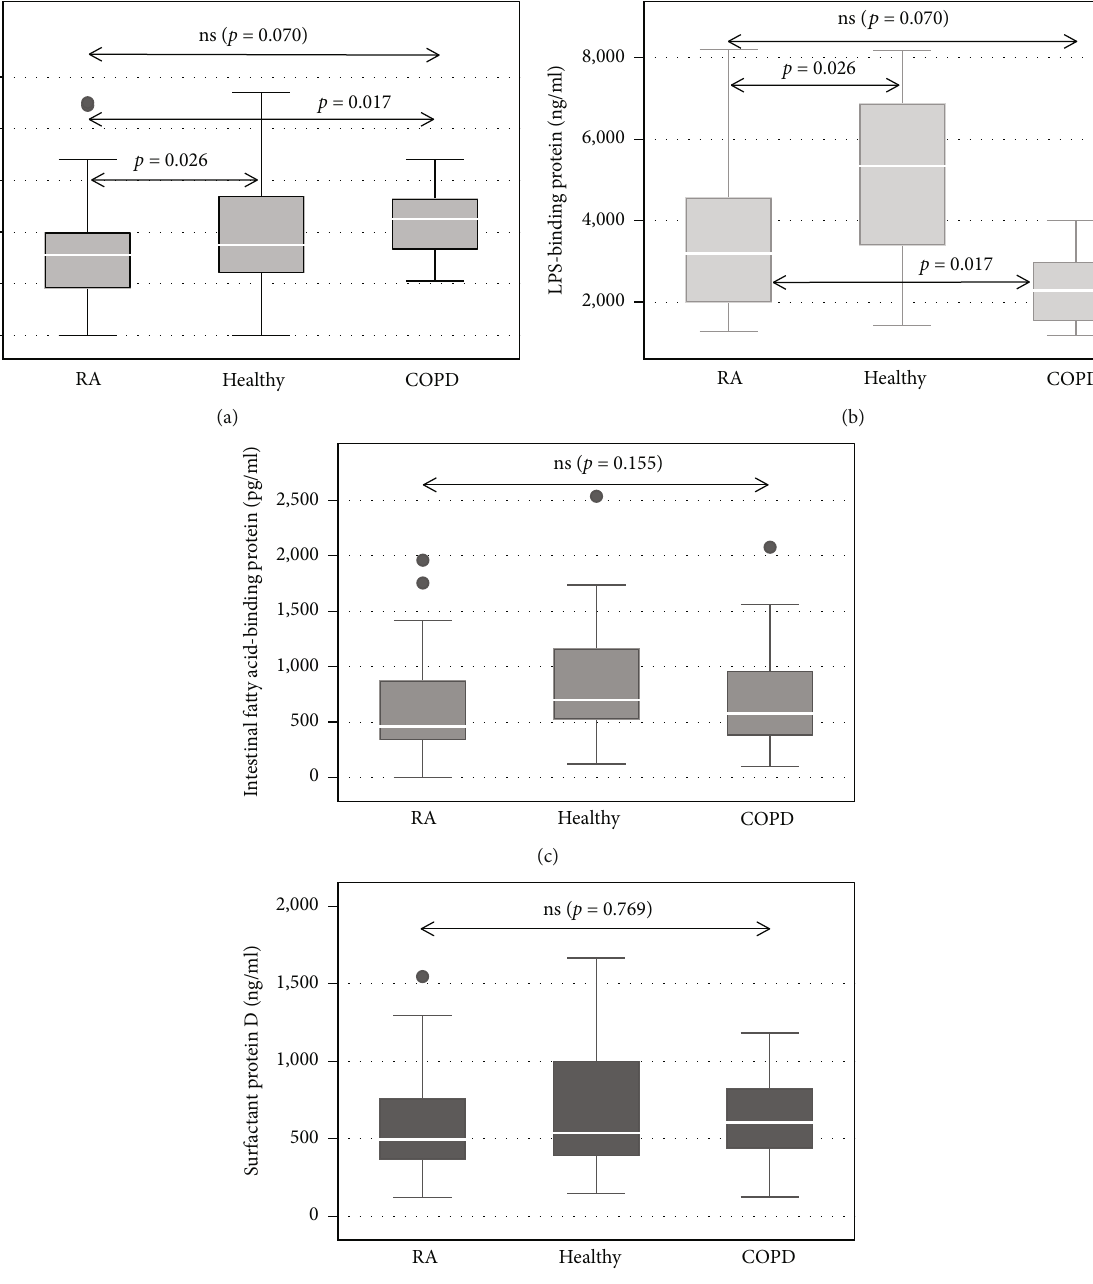
Figure 1: Box and whisker graphs showing median concentrations of the four biomarkers and statistical di ff erences between the groups as per Dunn ’ s post hoc